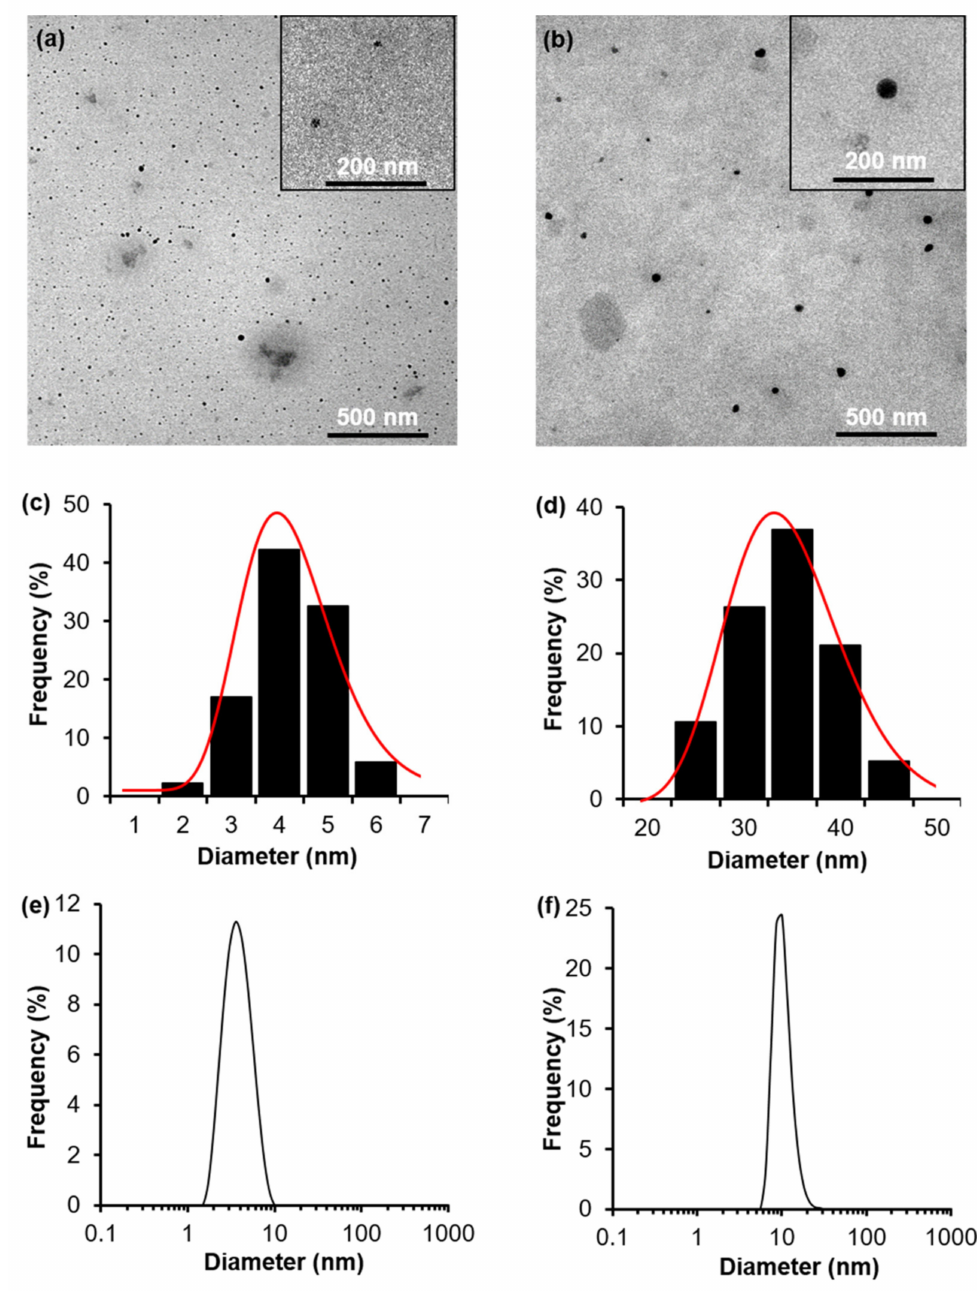
Figure 3. TEM ( a , b ), statistical graph from TEM ( c , d ) and DLS ( e , f ) results of G3.0 and G3.0 @mPEG,